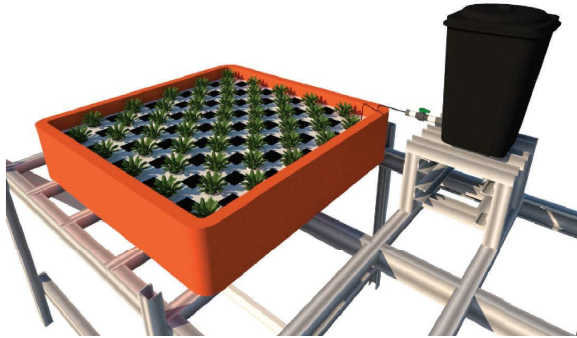
Figure 2: Self-fertigation system of pagoda